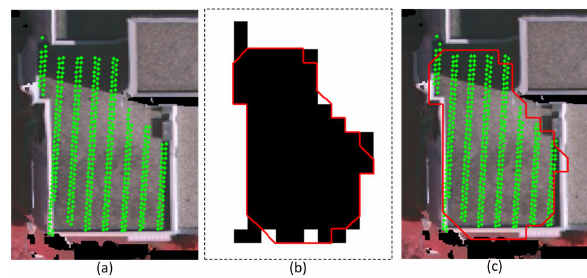
Figure 7: Extracting a 3D plane boundary: (a) LIDAR points on the plane, (b) Canny edge around a mask of resolution 0.25 m and (c) boundary after assigning only height values from the nearest LIDAR points to boundary in